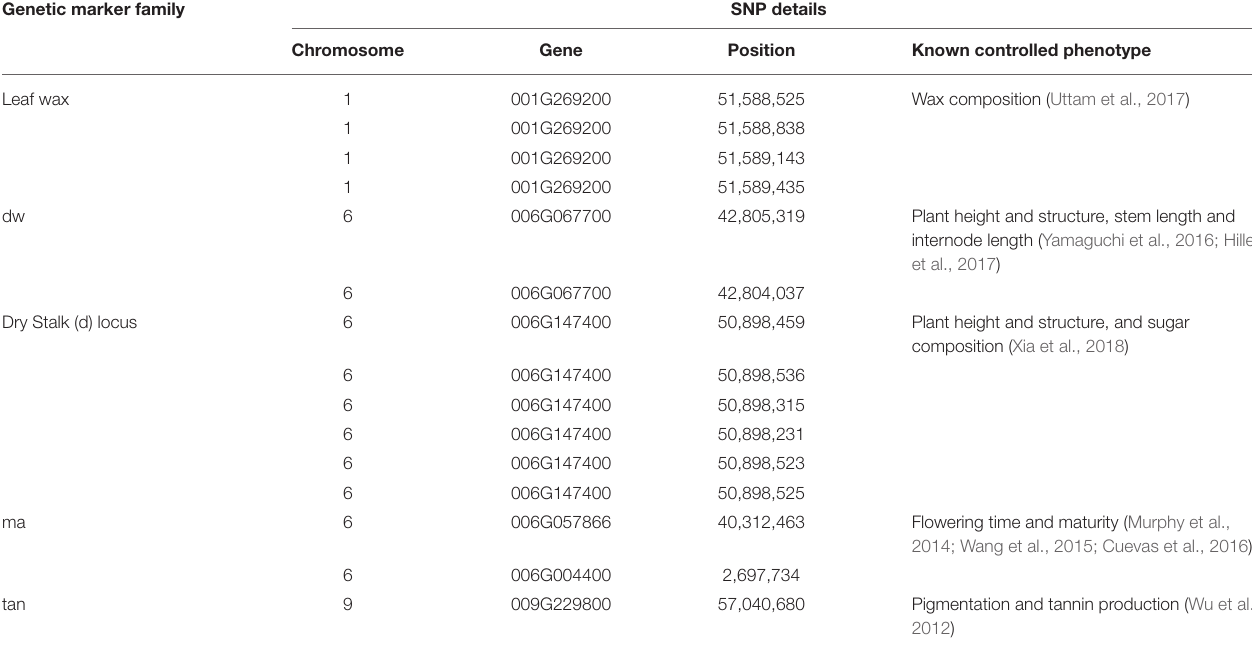
TABLE 1 | Details about the genetic marker families of interest. Genetic marker